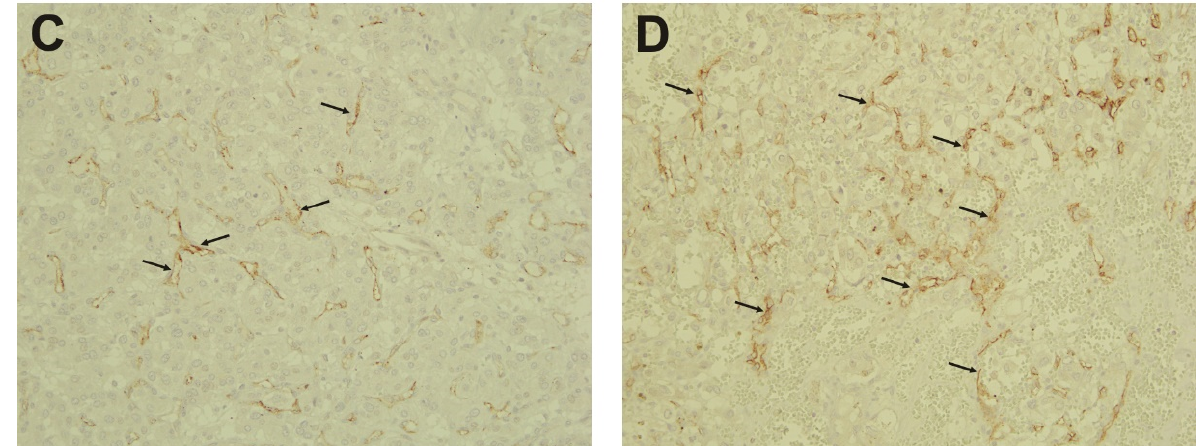
Figure 5. Immunohistochemistry. PSMA positivity and localization in Cluster 1 PPGLs. ( A ) SDHB-mutated bladder PGL (patient 1). ( B ) SDHB -mutated mediastinal PGL (patient 6). ( C ) VHL-mutated pheochromocytoma (patient 10). ( D ) VHL-mutated pheochromocytoma (patient 12). Brown PSMA staining in endothelial lining of tumor vessels is indicated by arrows.